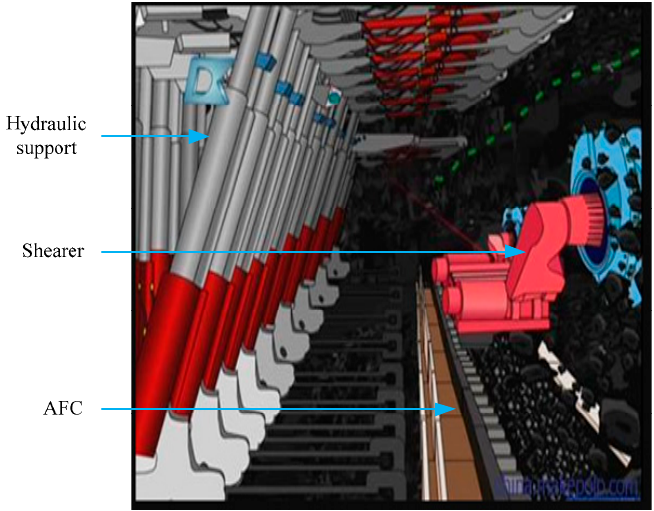
Figure 1. Composition of a longwall face.